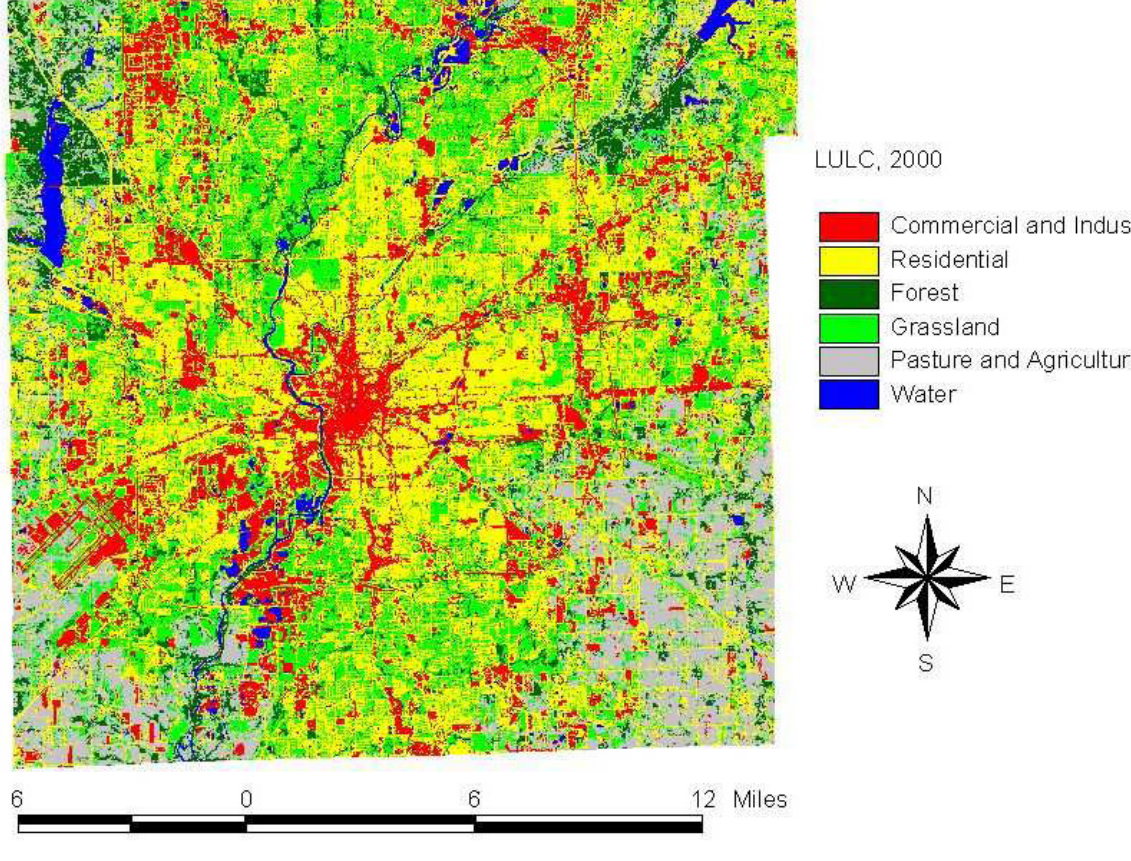
Figure 1. Land-use/land-cover map of Indianapolis, United States, derived from a Landsat ETM+ image of June 22,